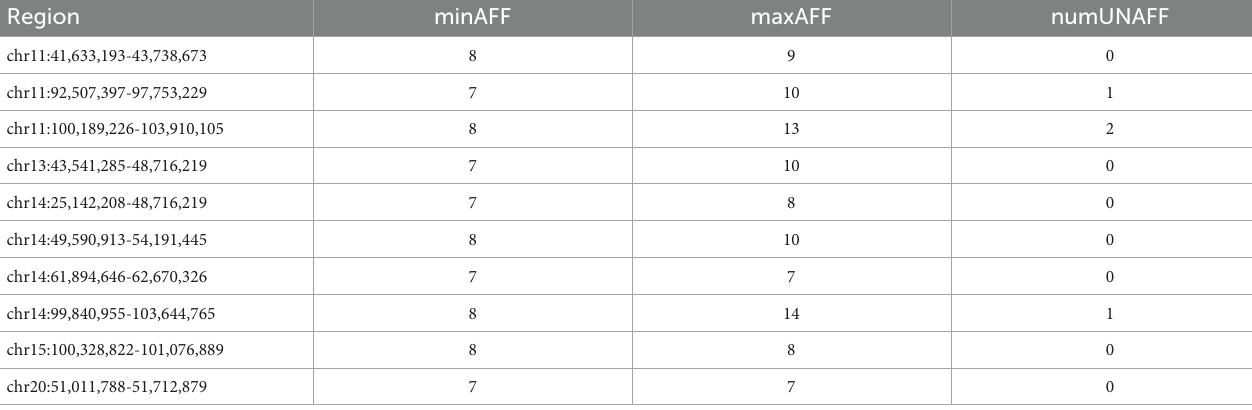
TABLE 5 A list of regions with runs of homozygosity (ROH) in multiple Saudi Schizophrenia cases where few to zero are observed in controls. Region minAFF maxAFF numUNAFF